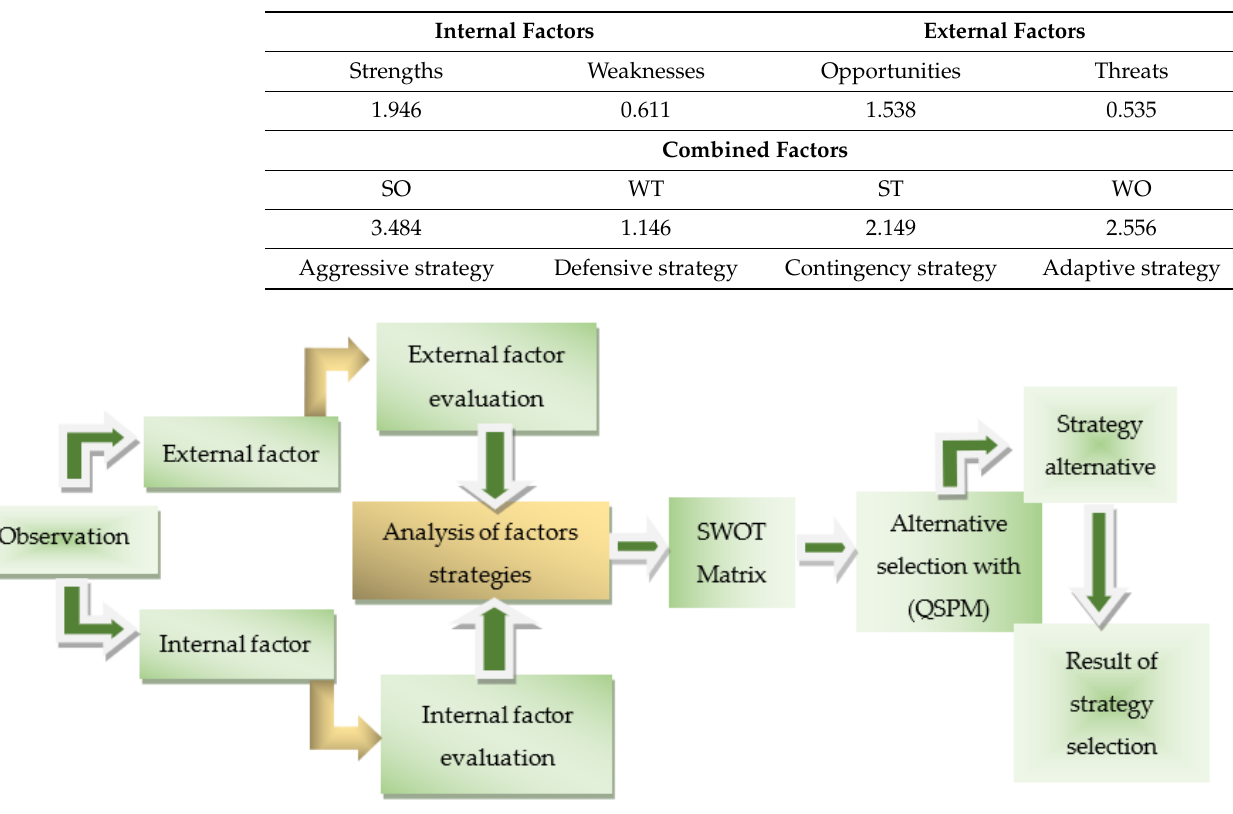
Figure 3. Conceptual framework of the study (adapted from Wati et al. [59]). Table 1. Internal Factor Analysis Summary (IFAS) to improve water productivity.